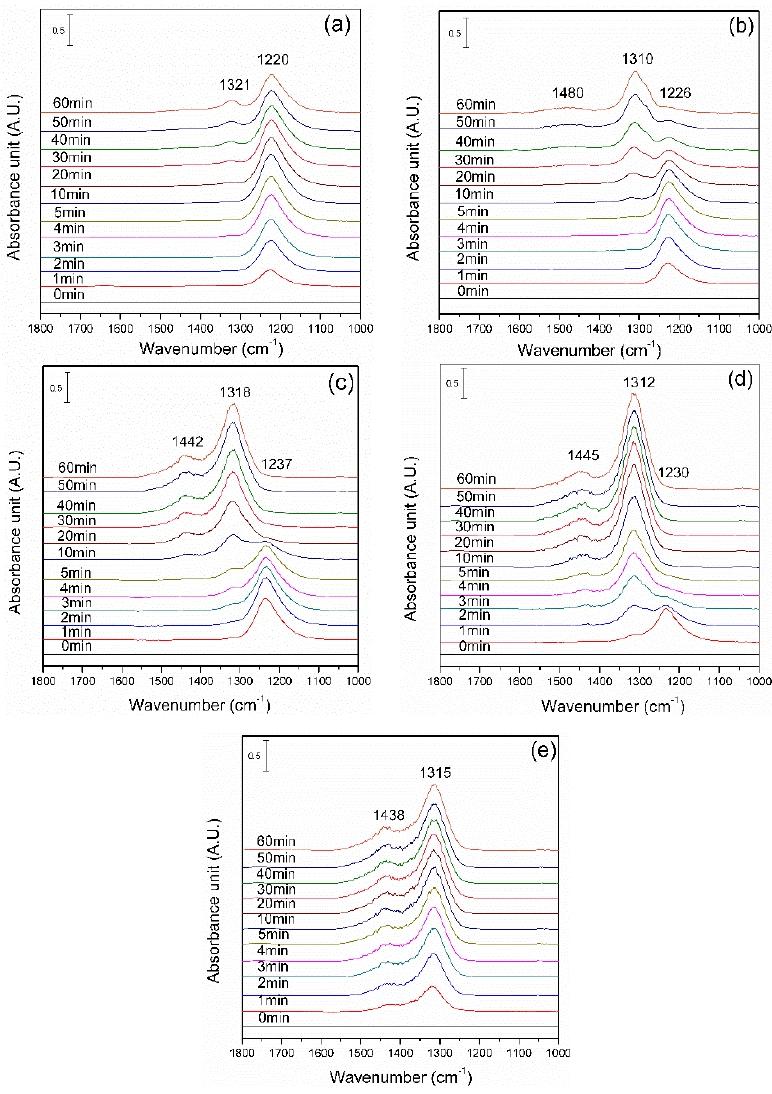
Figure 9. In situ DRIFTS spectra of NO x adsorption on Mn15 sample at 150 °C ( a ), 200 °C ( b ), 250 °C ( c ), 300 °C ( d ), 350 °C ( e ). Table 6. Characteristic vibrations of adsorbed NO x species on Mn0, Mn5, Mn15 catalysts.